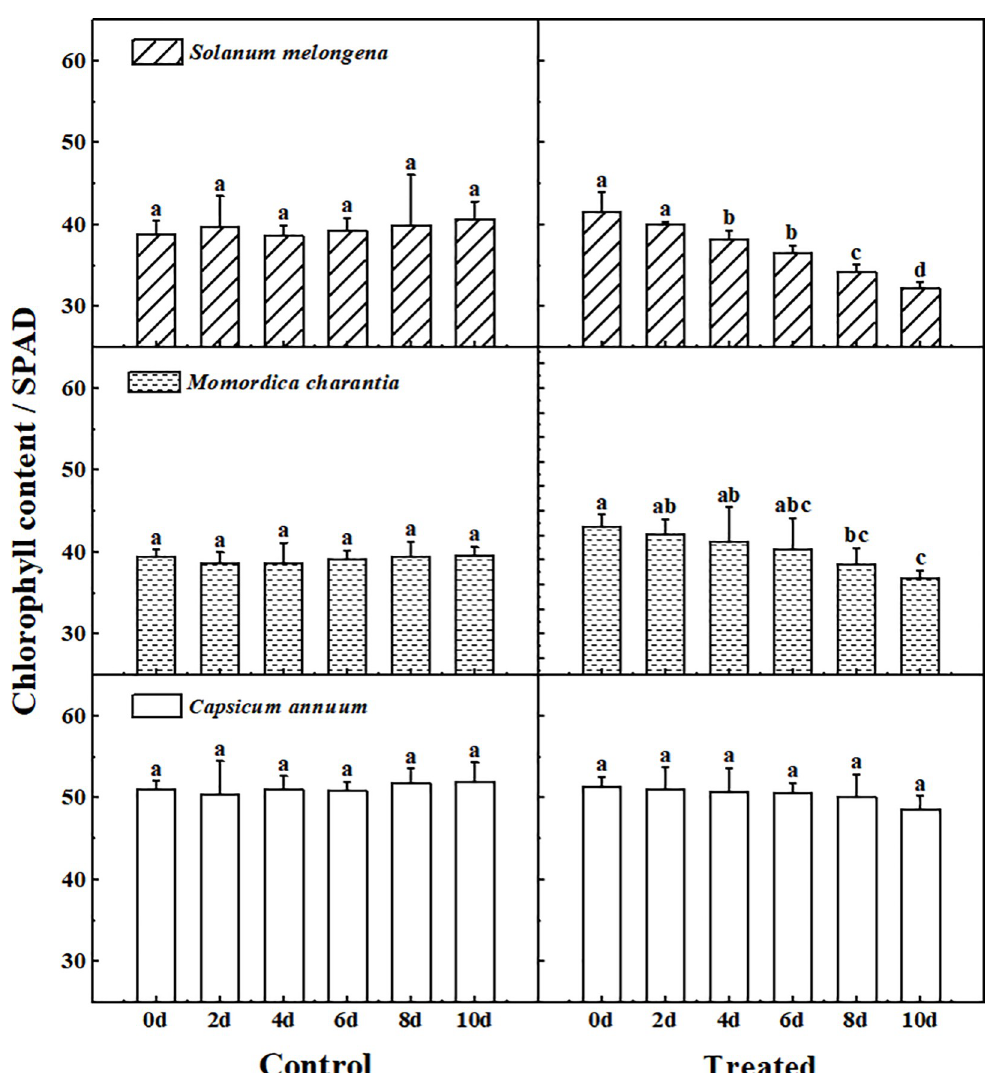
Fig 1. The response of chlorophyll to normal watering (Control) and salt water irrigation (Treated) in Solanum melongena , Momordica charantia , Capsicum annuum . The single salt solution (NaCl, 150 mmol/L) was watered once a day (25 ml per pot) for a total of 10 days, seedling leaves were randomly sampled every 2 days to determine the chlorophyll. Error bars represent standard errors of Chlorophyll with 4–5 replicates measurements. The same letter in each picture represents no significant difference (Duncan test, P < 0.05, n = 4–5).